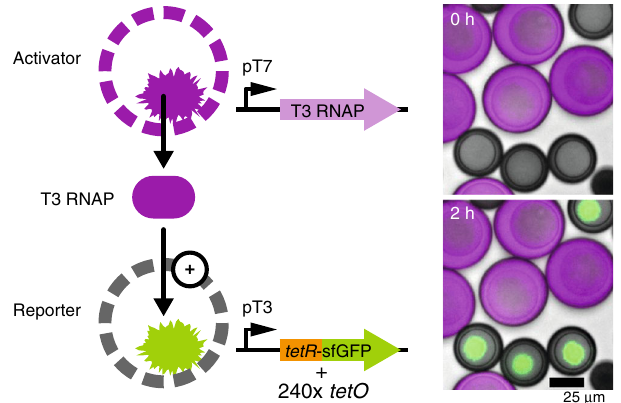
Fig. 3 Communication between cell-mimics via a diffusive genetic activator. Schematic of the two types of cell-mimics communicating through a distributed genetic activation cascade. Micrographs show a merge of bright fi eld images with rhodamine B fl uorescence in the membranes of activators (magenta) and fl uorescence of TetR-sfGFP (green) in the hydrogel nuclei of reporters directly after addition of TX-TL and after 2 h of